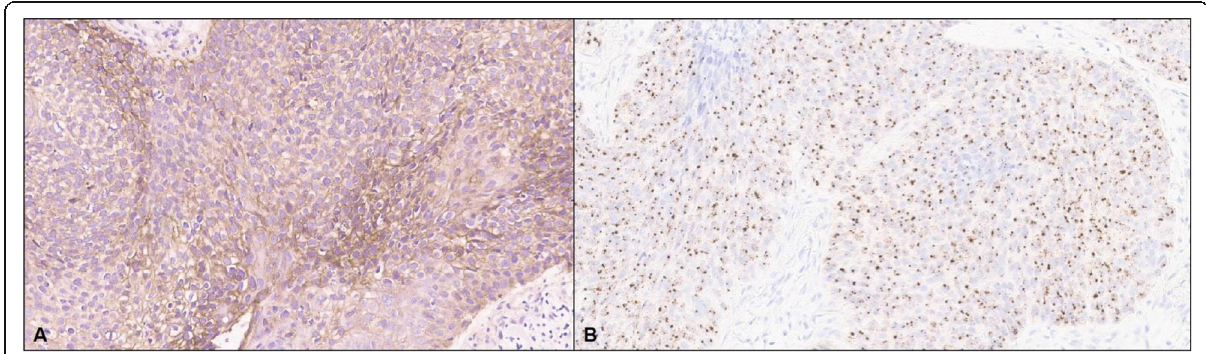
Fig. 4 a . EGFR by immunohistochemistry showing strong membranous staining. b . High risk HPV 33 is positive by in situ hybridization, supporting the diagnosis of HPV-related multiphenotypic carcinoma involving the